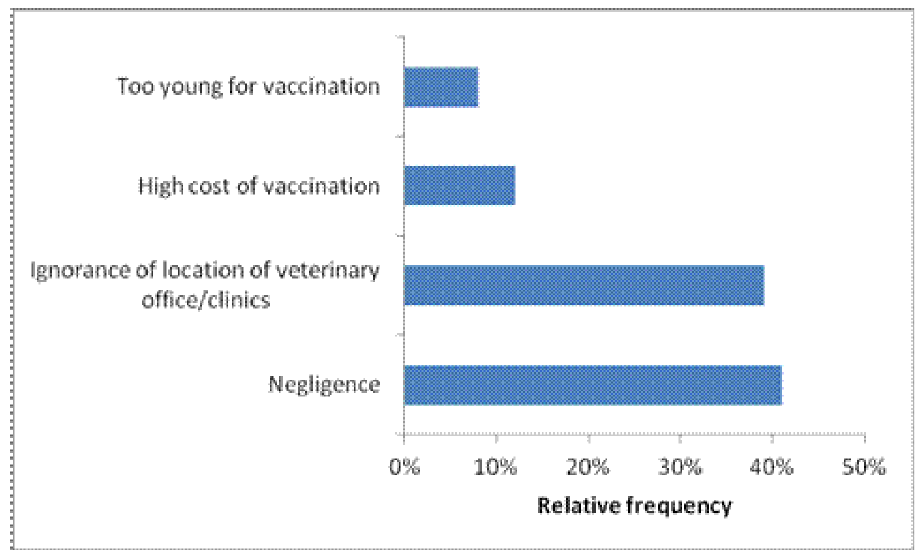
Fig 2. Reasons of non-vaccination of dogs by owners (n = 64) in Lemba commune, Kinshasa/DRC.